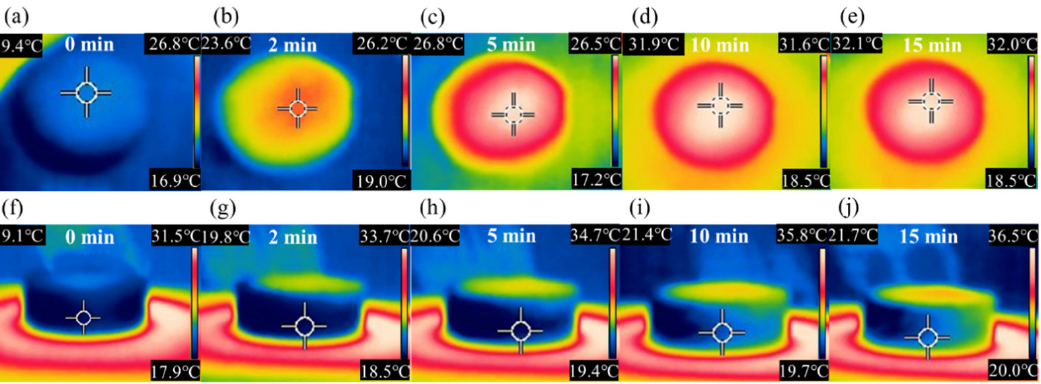
Figure 6. Infrared images of ( a – e ) the top of the device and ( f – j ) the cold end of the thermoelectric layer of the device at different illumination times.